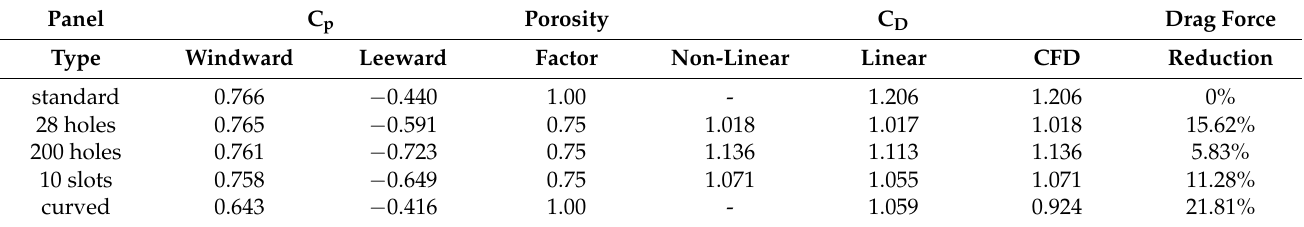
Table 1. Drag coefficient comparison between the standard and porous panels.